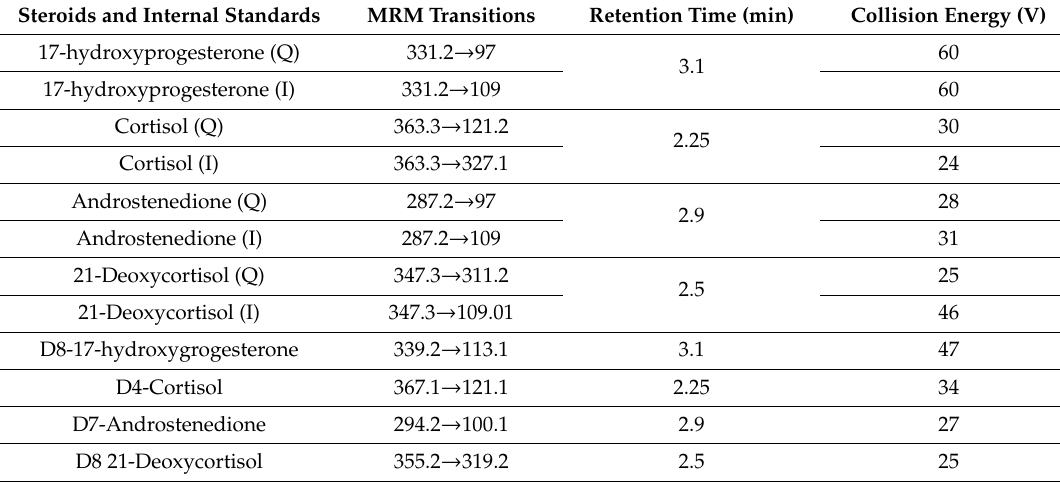
Table 1. Parameters for detection of steroids and internal standards. Table 1 provides the multiple reaction monitoring (MRM) transitions, retention times, and collision energy for each steroid and its corresponding internal standard. Q = quantifying transition, I = identifying transition, MRM = multiple reaction monitoring.